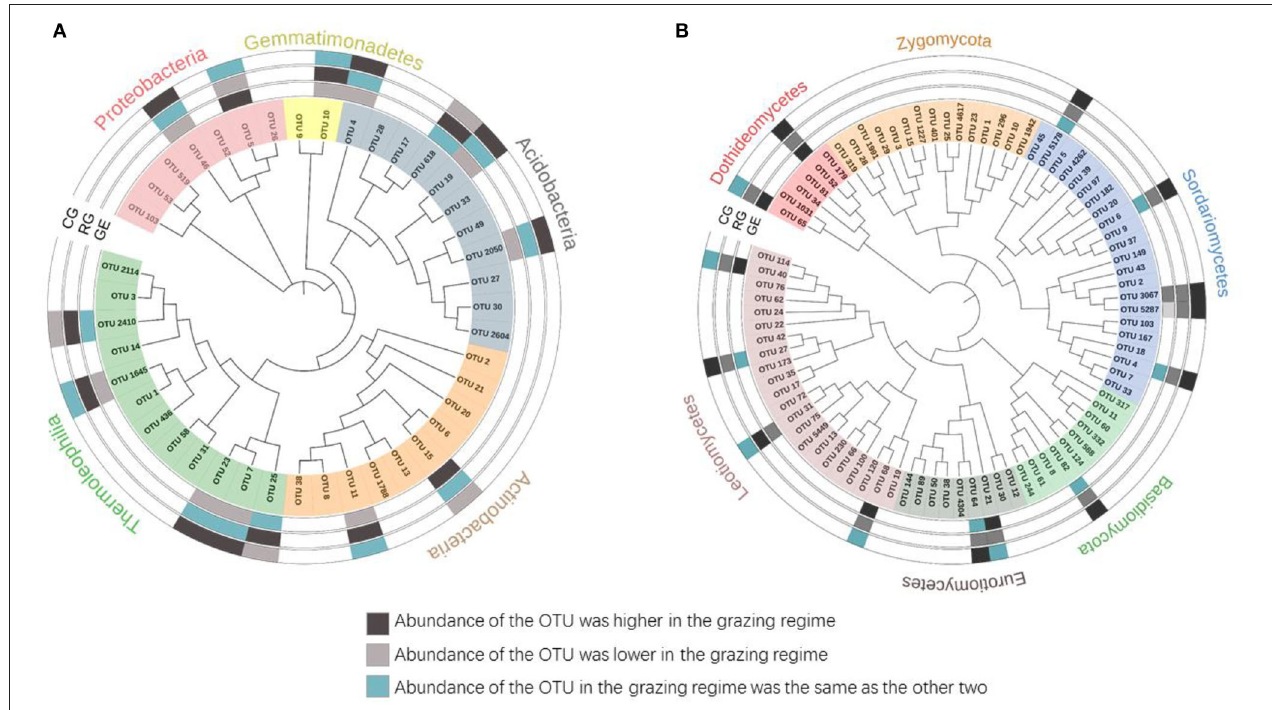
FIGURE 5 | Phylogenetic tree of dominant bacterial (A) and fungal (B) taxa. GE, grazing exclusion; RG, rotational grazing; and CG, continuous grazing.